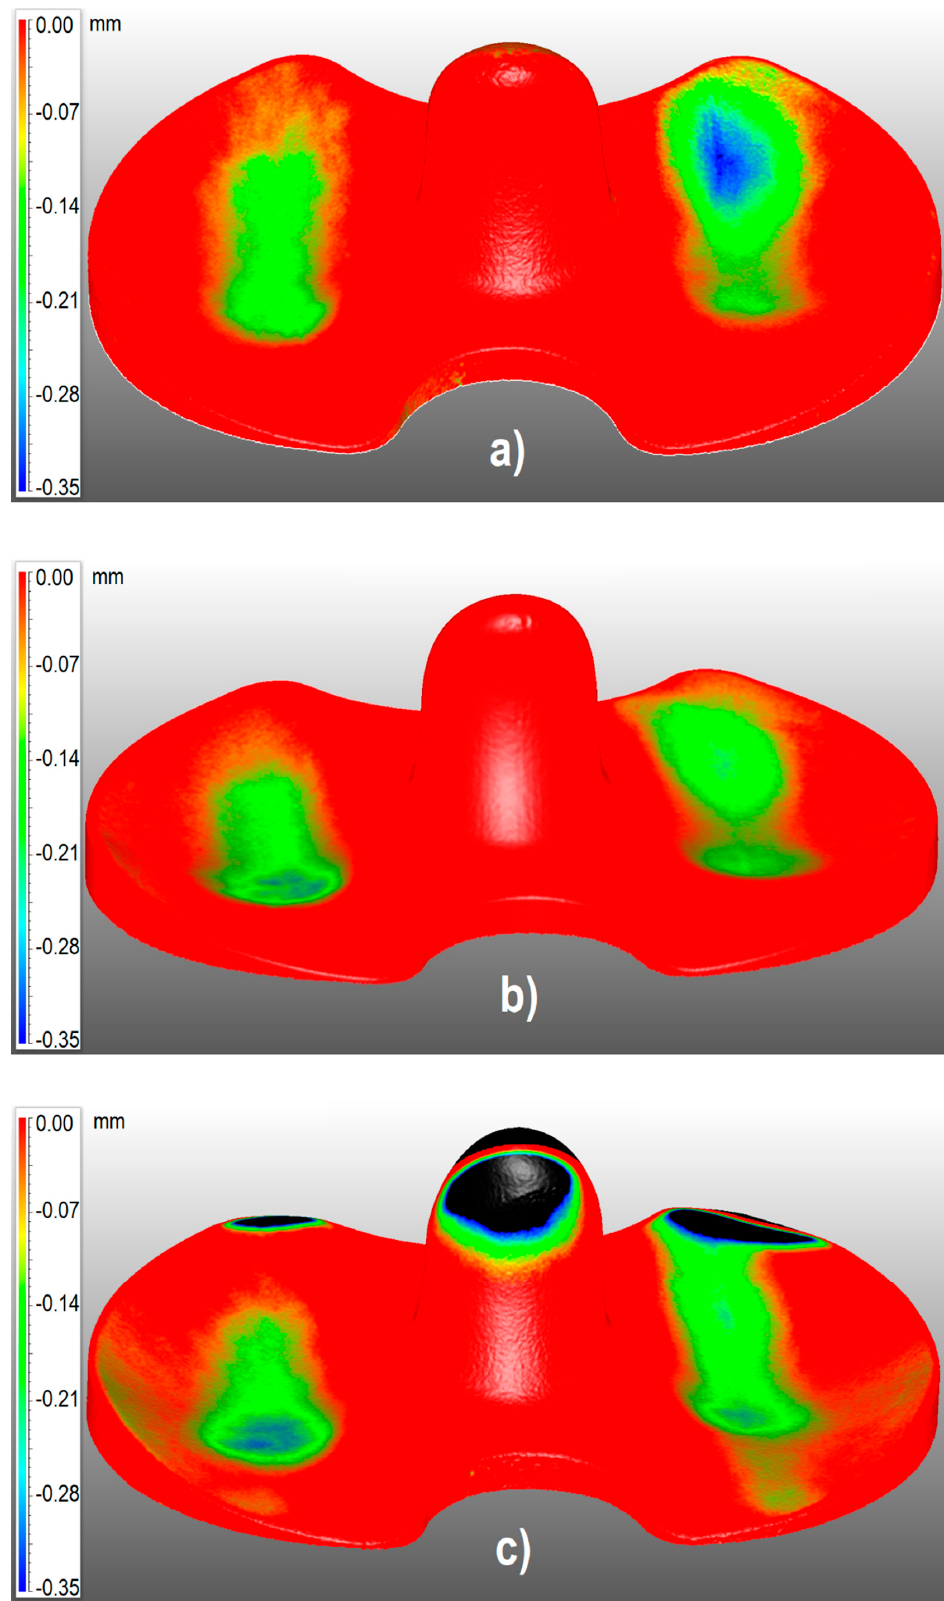
Figure 5. Three-dimensional wear map of meniscus #1 ( a ), #2 ( b ), #3 ( c